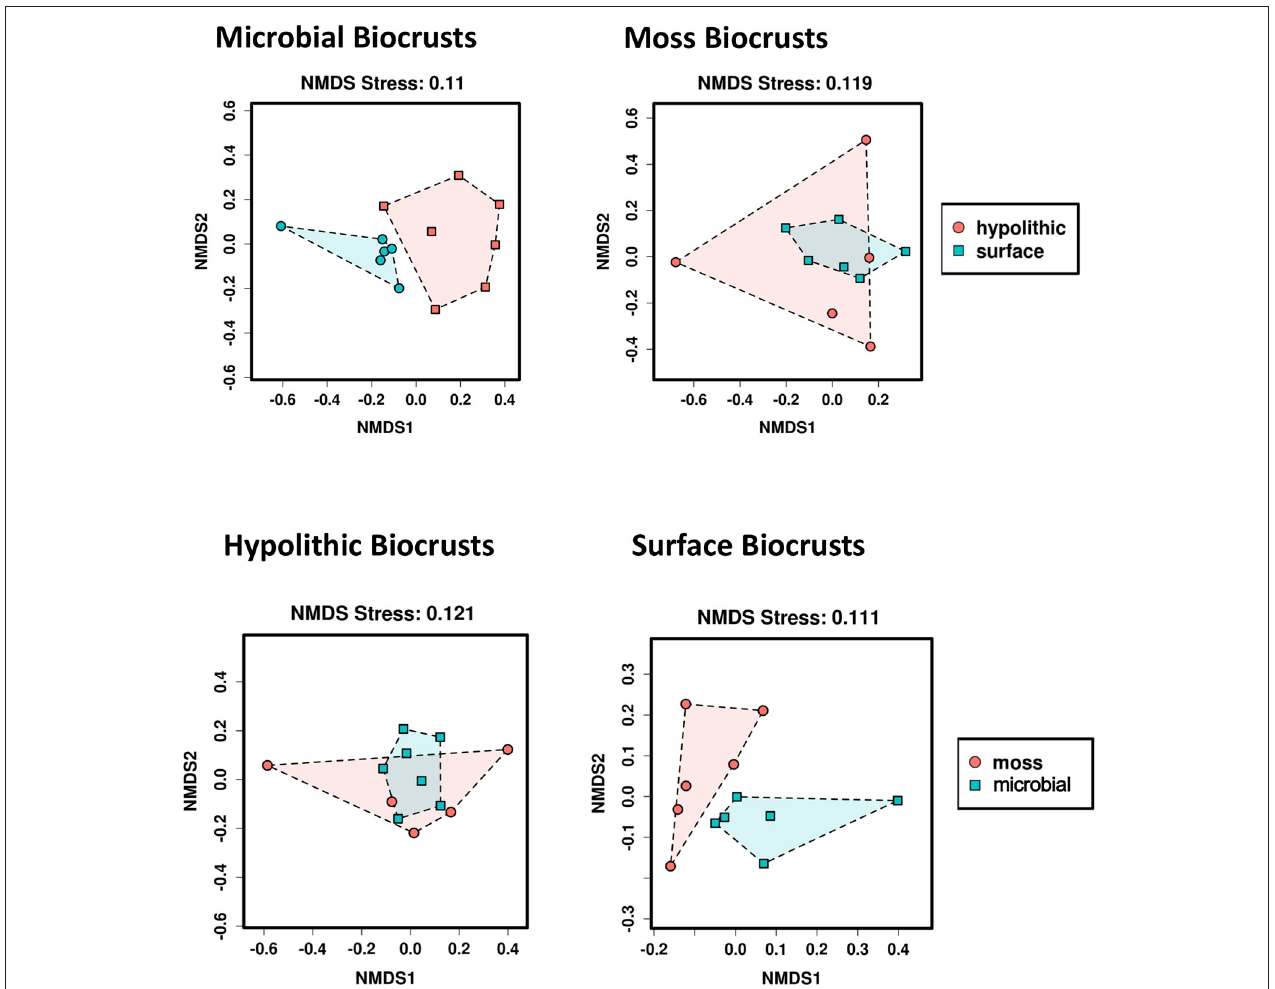
FIGURE 3 | Plots for pairwise non-metric multidimensional scaling (NMDS) ordinations of Bray-Curtis distances. Upper panels show comparisons of microbial (Left) and moss (Right) biocrusts from hypolithic and surface niches; lower panels show comparisons of microbial and moss biocrusts from hypolithic (Left) and surface (Right) niches.